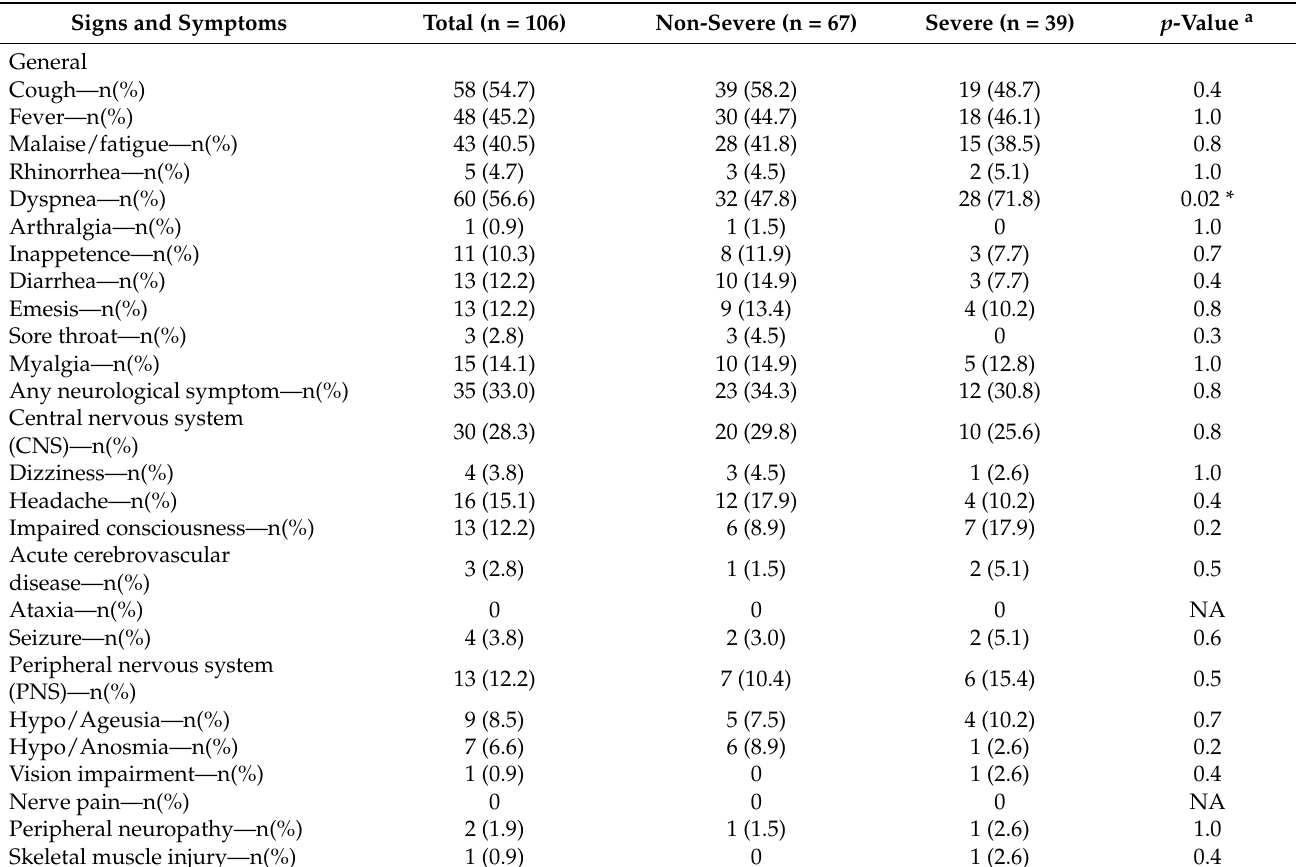
Table 2. Patient signs and symptoms upon hospital admission, according to COVID-19